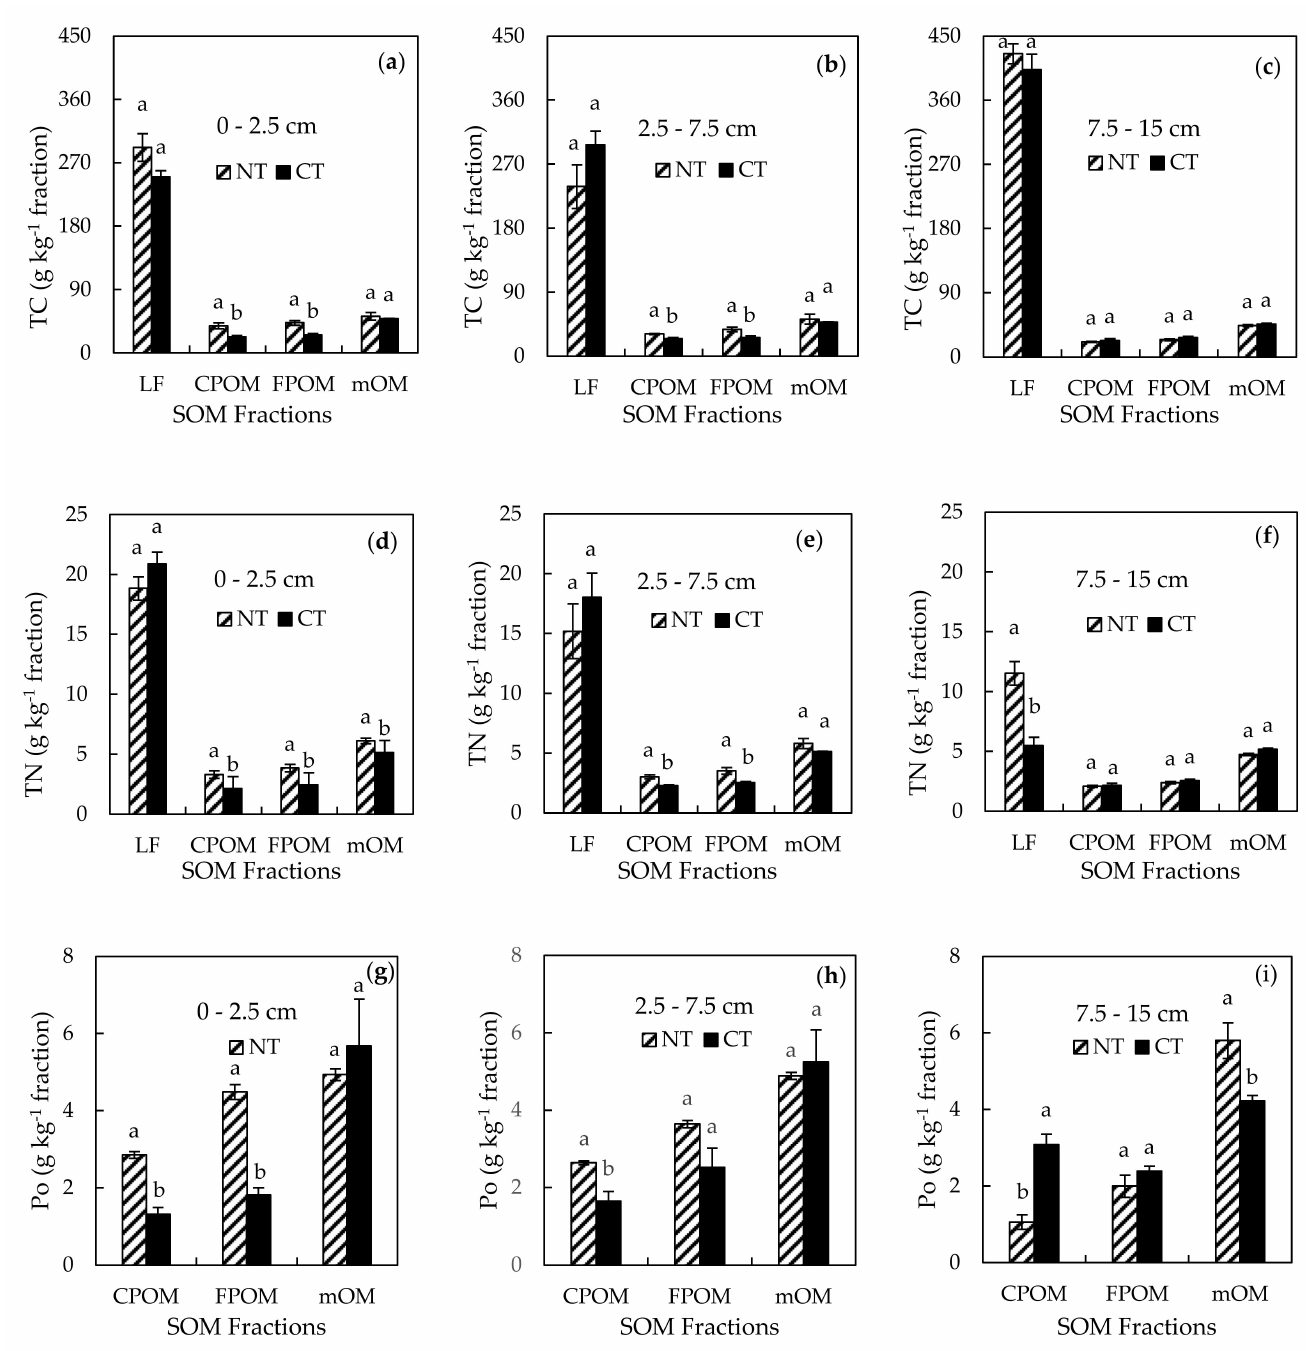
Figure 2. Total carbon (TC); -( a – c ) (g C kg − 1 fraction), total nitrogen (TN); ( d – f ) (g N kg − 1 fraction), and organic phosphorus (Po); ( g – i ) (P kg − 1 fraction) of SOM fractions by physical fractionation of Andosols from No-Tillage (NT) and Conventional Tillage (CT) systems. Different letters show significant differences for the tillage treatments of each fraction, according to Student’s t -test ( p <